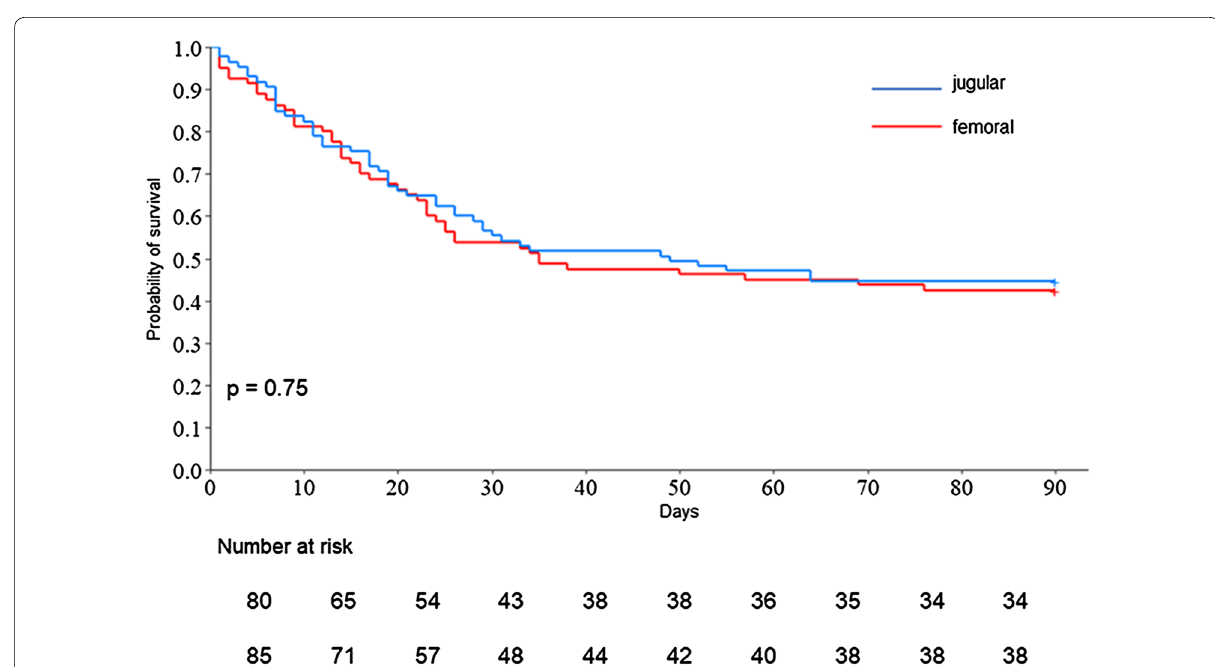
Fig. 2 Kaplan–Meier survival curves and 90‑day outcome. Red line indicating jugular group in which return cannula site of VV‑ECMO is femoral vein. Blue line depicting femoral group in which return cannula site of VV‑ECMO is internal jugular vein. The difference between jugular and femoral group was not significant ( p 0.75 by the log‑rank =